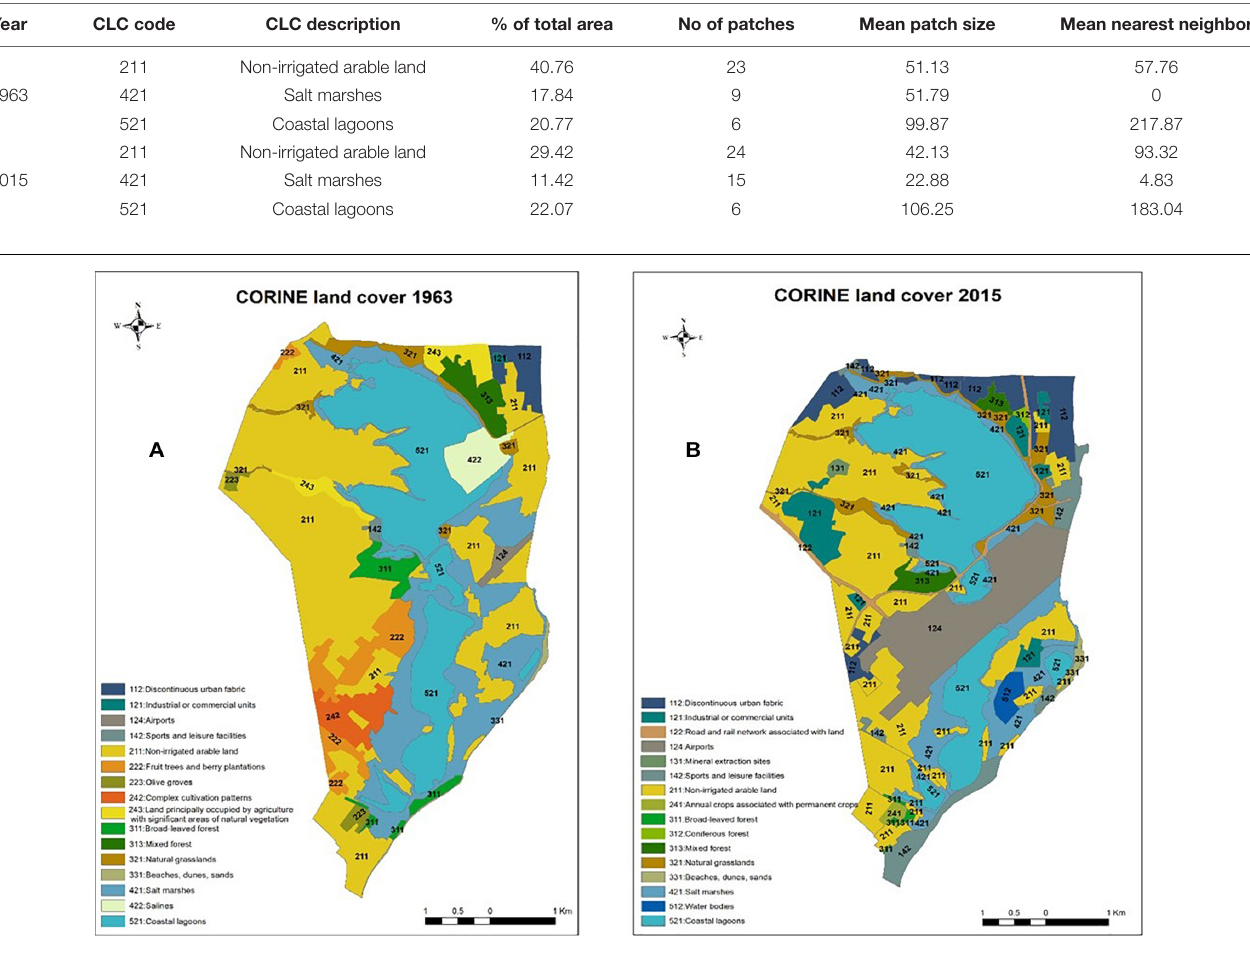
FIGURE 2 | Land cover in 1963 (A) and 2015 (B) in Larnaca Salt Lake.